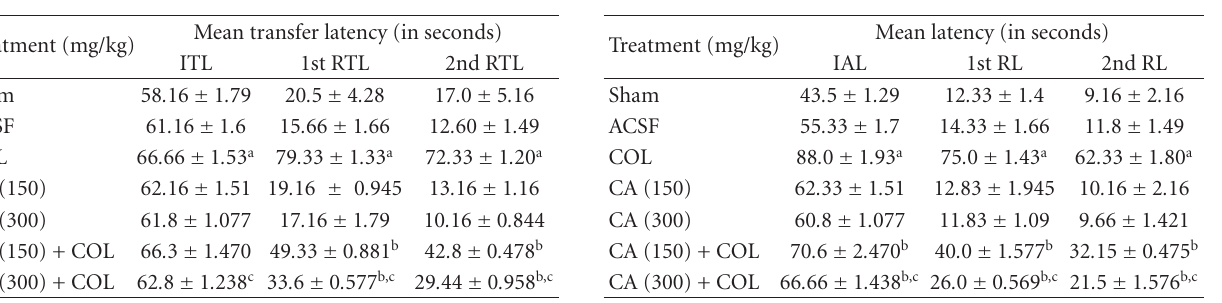
Table 2: E ff ect of Centella asiatica (CA; 150 and 300 mg/kg, PO) on memory performance in elevated plus maze paradigm in intracerebroventricular colchicines- (COL-) injected rats.